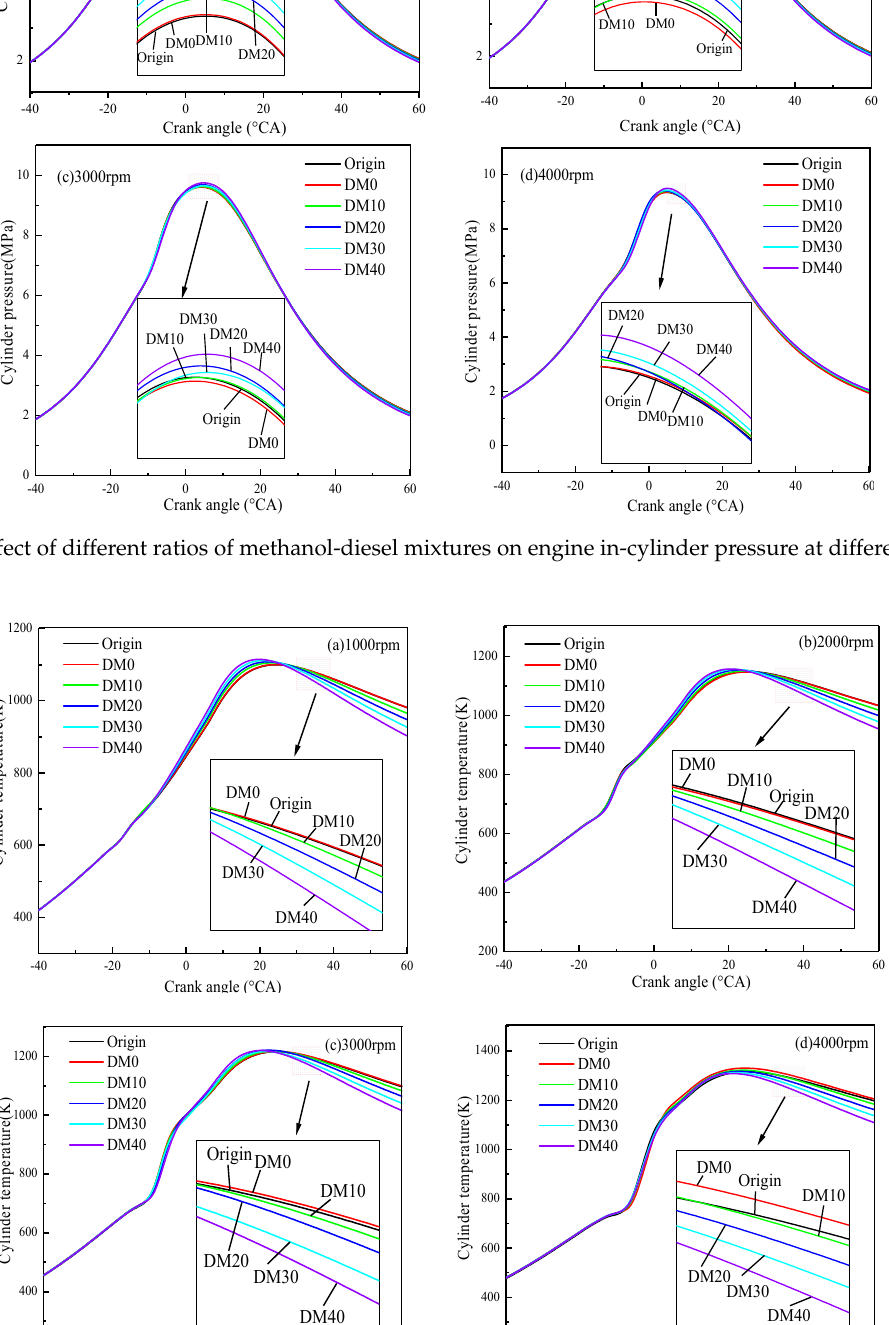
Figure 5. Effect of different ratios of methanol-diesel mixtures on engine in-cylinder temperature at different speeds. It can be seen from Figures 4 and 5 that the pure diesel model (with DOC, i.e., origin curve) has only slight changes in both in-cylinder pressure and in-cylinder tem- perature compared with the modified pure diesel model (with DOC + DPF + SCR, i.e., DM0 curve). This is caused by exhaust back pressure. For example, at 3000 rpm, the origin curve is smaller than the DM0 curve, as seen in Figures 4c and 5c, compared to the DM0 cylinder pressure. The presence of the aftertreatment system makes the EBP increase and causes the cylinder pressure to decrease. Similarly, the EBP becomes more extensive, and the gas is not quickly exhausted, causing the cylinder temperature to in- crease. 3.2. The Engine Economic Characteristic 3.2.1. Engine Power and Torque Figure 6 shows the effects of different ratios of methanol-diesel mixtures on the en- gine power and torque at different speeds. The results show that the power and torque of the engine decrease as the ratio of methanol in the methanol-diesel fuel mixture increas- es. In addition, the larger the ratio of methanol, the greater the decrease in power and torque performance. Compared with DM0, the power decreased by 1.07–3.76%,